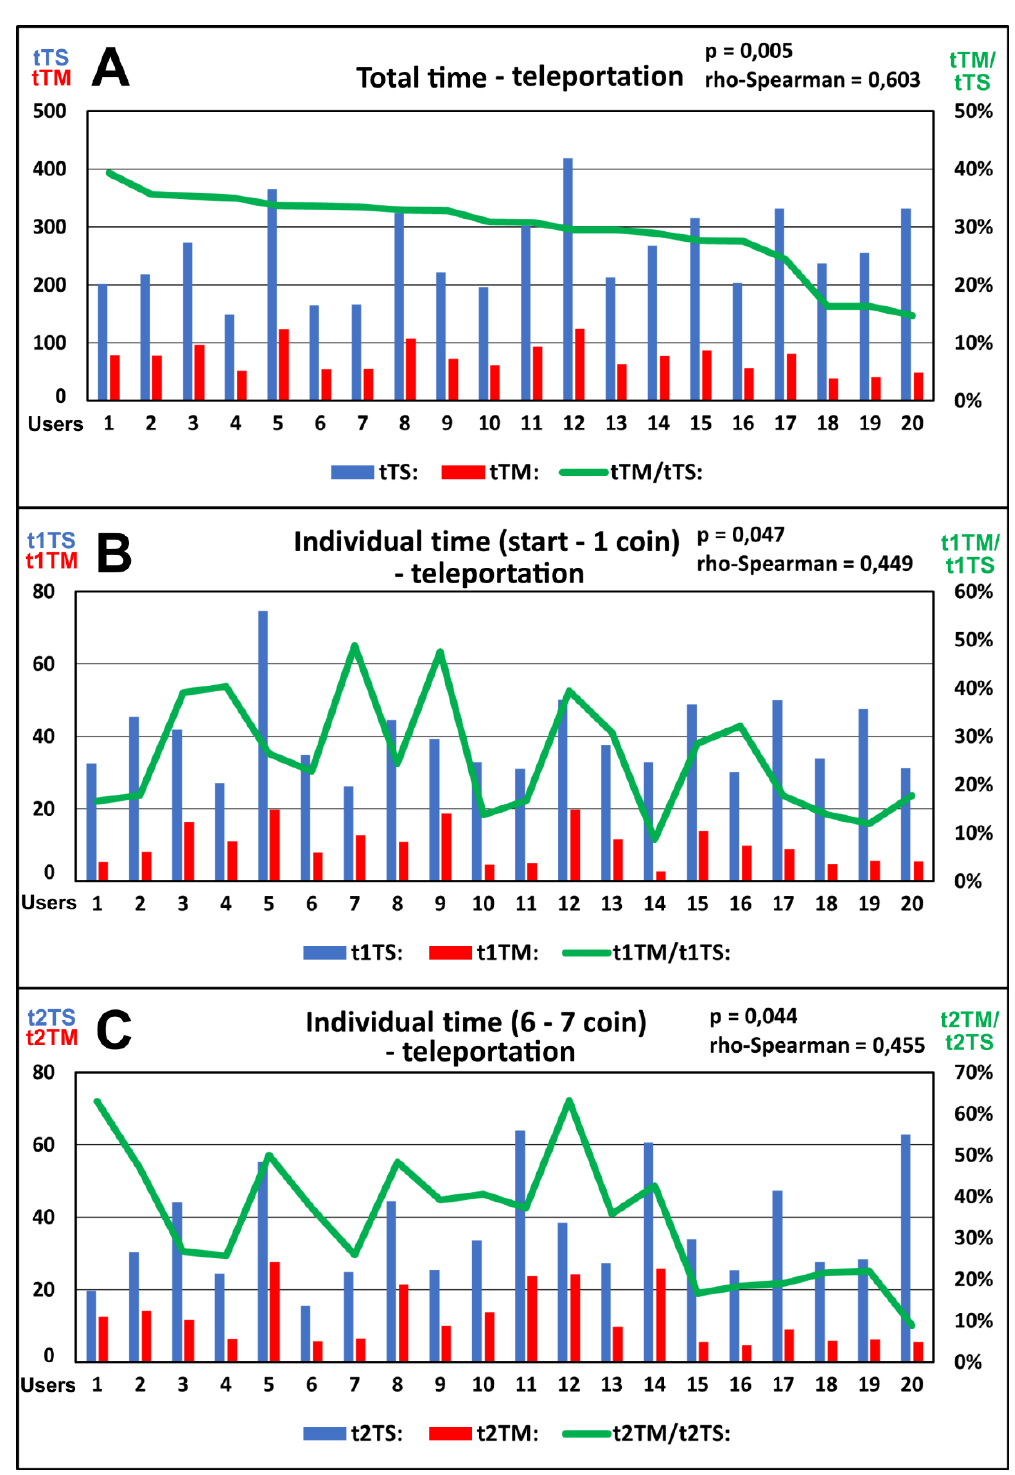
Figure 7. Visualization of time data for teleportation.